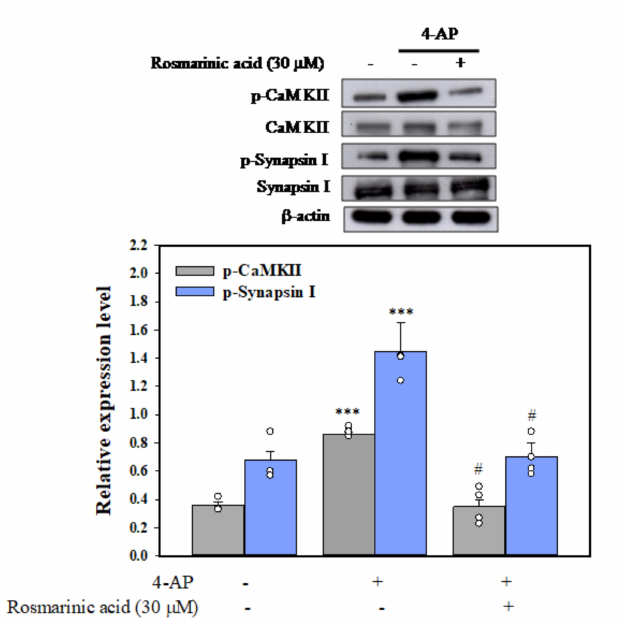
Figure 4. Effect of rosmarinic acid on CaMKII and synapsin I phosphorylation evoked by 4-AP. Rosmarinic acid or KN62 was added 10 min before the addition of 4-AP. Data are mean ± SEM ( n = 5 per group). *** p < 0.001 compared with the control group. # p < 0.001 compared with the 4-AP-treated